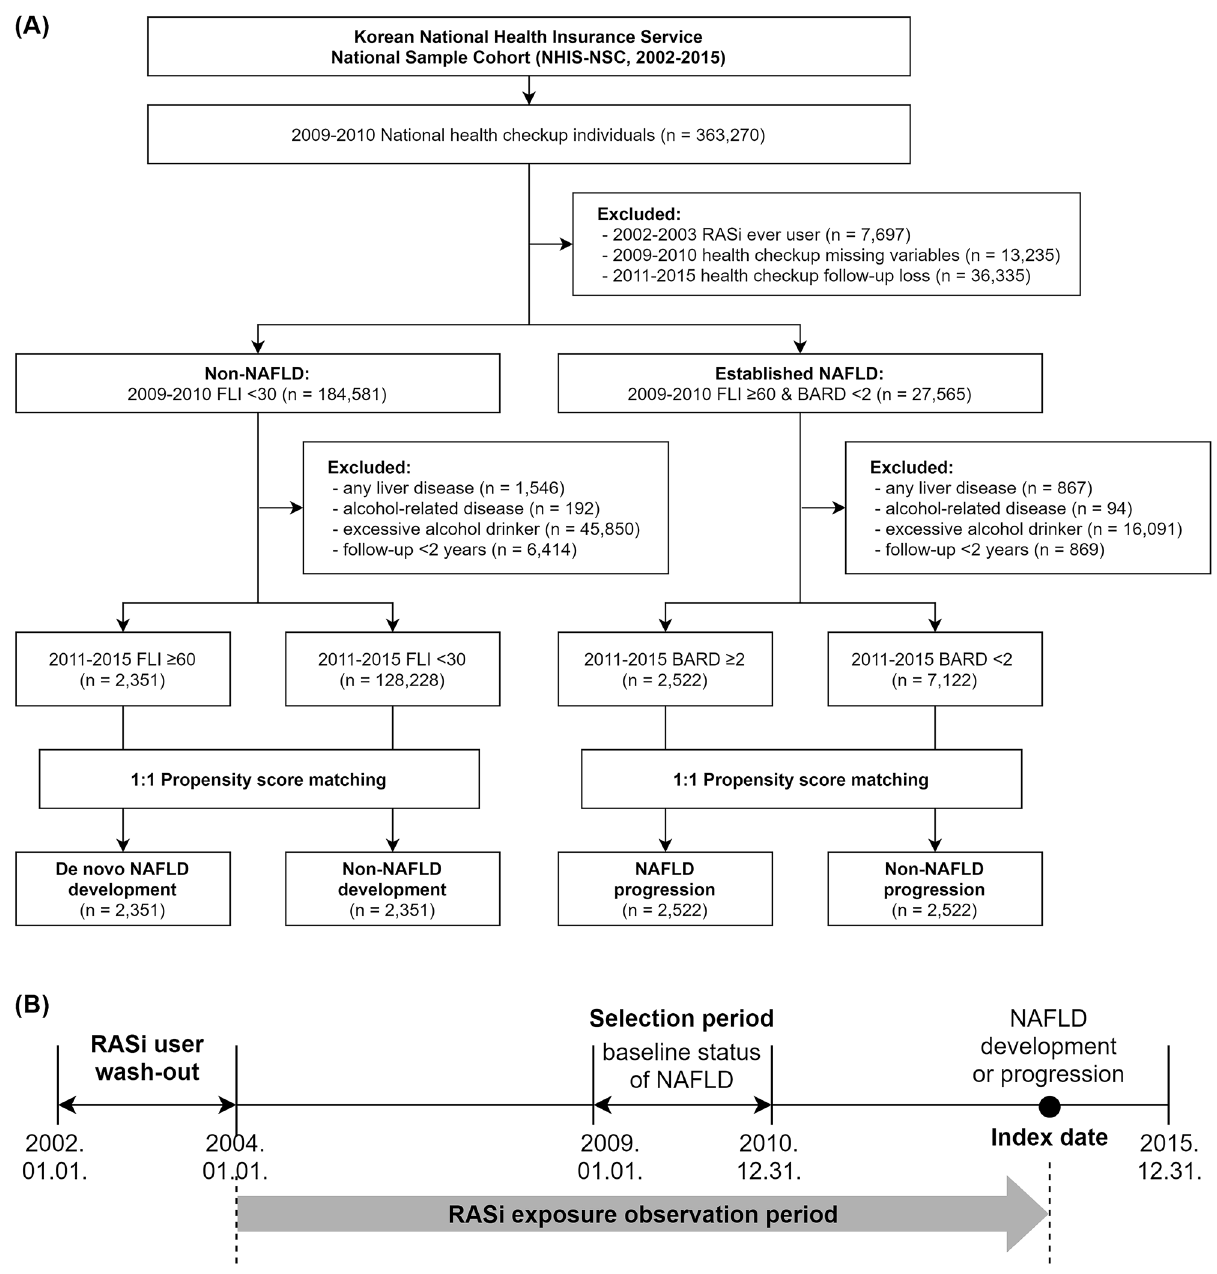
Figure 1. Diagrams depicting the nested case–control study design. ( A ) Flow chart of inclusion and exclusion criteria of the study population. ( B ) Timeline of the